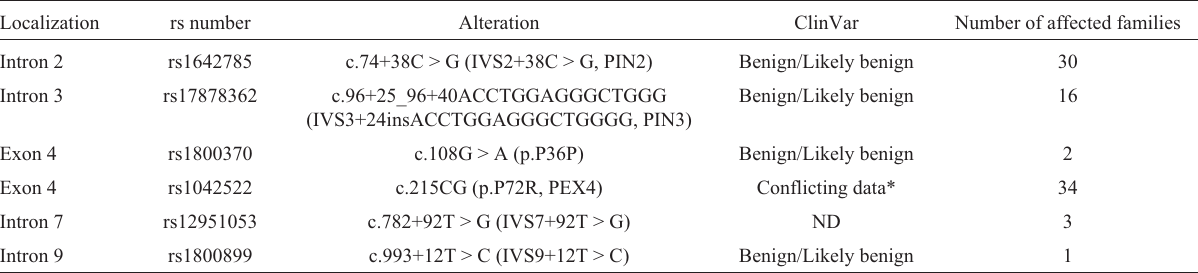
Table 4 - TP53 sequence variants identified in the 40 families fulfilling LFL syndrome criteria.